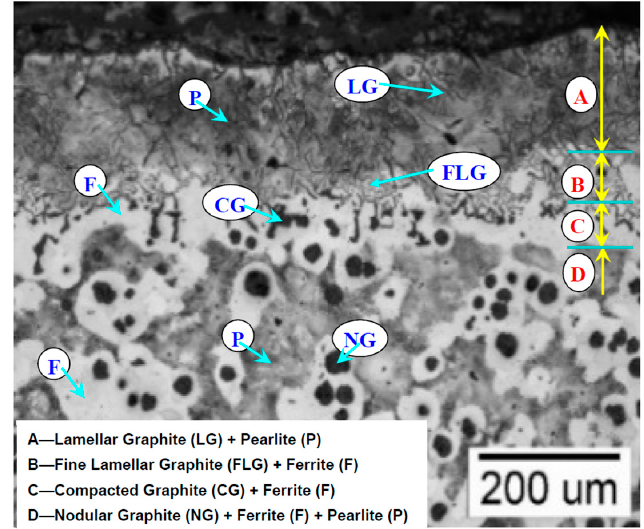
Figure 9. Graphite morphologies and metal matrix make-up at the metal–resin sand mould interface. Parameters’ evolution on the casting section. The influence of the steel sheet thickness on the degenerated graphite surface layer (skin) thickness is shown in Figure 10.